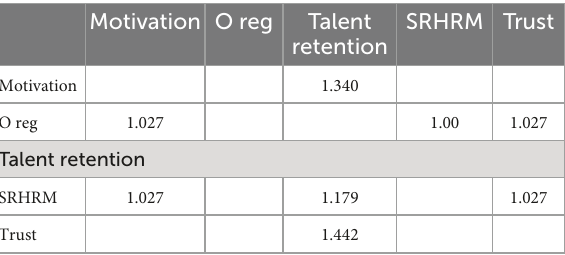
TABLE 5 Result of inner VIF